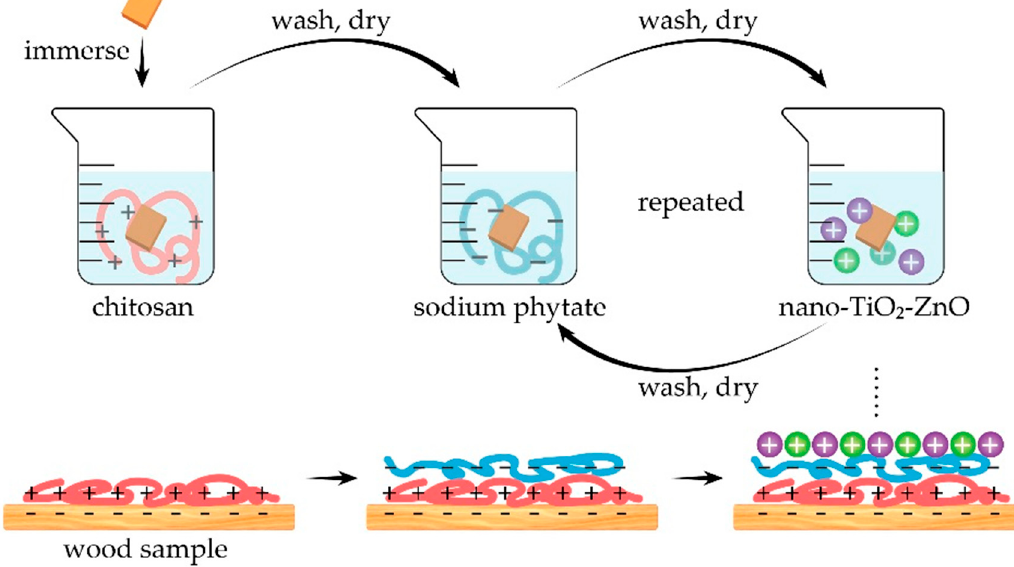
Figure 31. Scheme of the Layer-by-Layer process. Reprinted from [57] under CC BY 4.0 license.